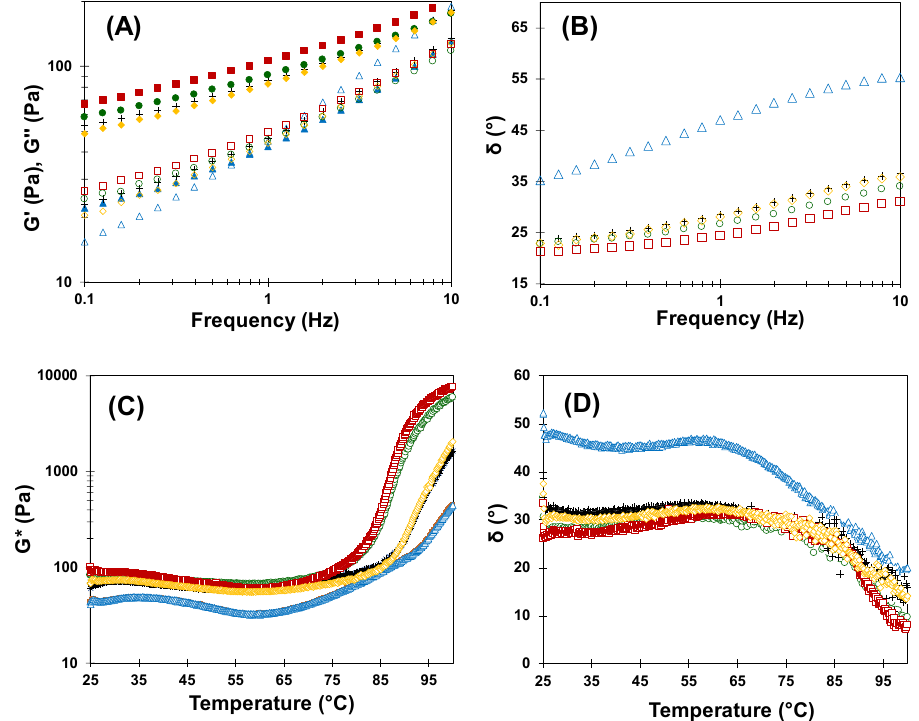
Figure 2. The impact of sucrose replacement by AS and PHAS on frequency ( A , B ) and temperature ( C , D ) sweeps of the muffin batters: control (blue triangles), PHAS-50 (black crosses), AS-50 (yellow diamonds), PHAS-100 (green circles), and AS-100 (red squares). In Figure 2A, two variables are shown: G ′ (full data points) and G ″ (empty data points).